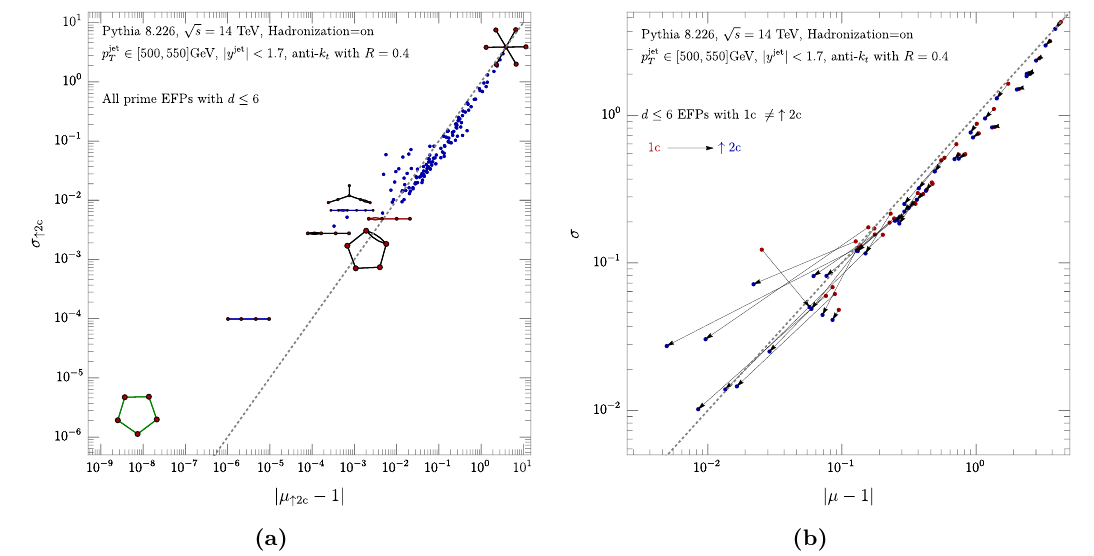
Figure 9. Scatter plot for | µ − 1 | and σ of the prime EFPs up to degree 6. Left: in the 2-collinear approximation. Right: the result in the 1- (red) and 2-collinear (blue) approximation, connected by an arrow. We only show whose EFPs where the expression for 2-collinear is different; note the difference in scale. The dashed line indicates σ ’ | µ − 1 |